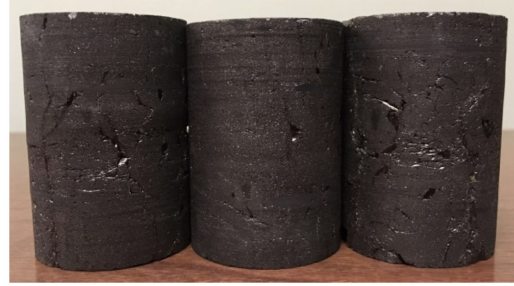
Figure 2. Typical samples prepared for the